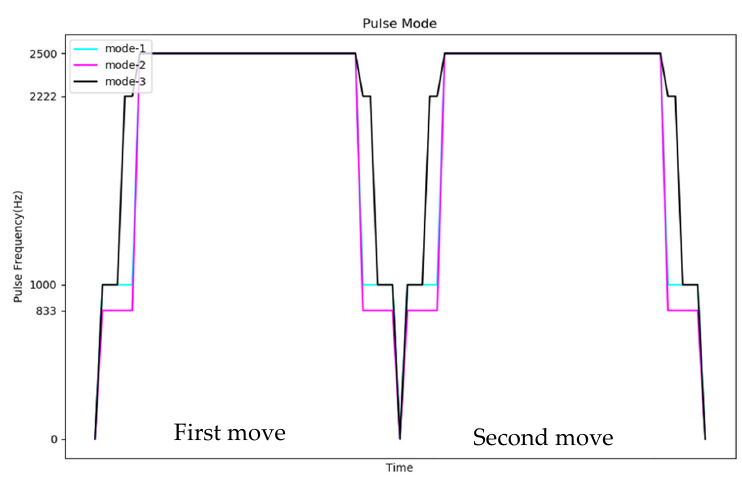
Figure 24. Time distribution diagram of pulse frequency in the first control mechanism.